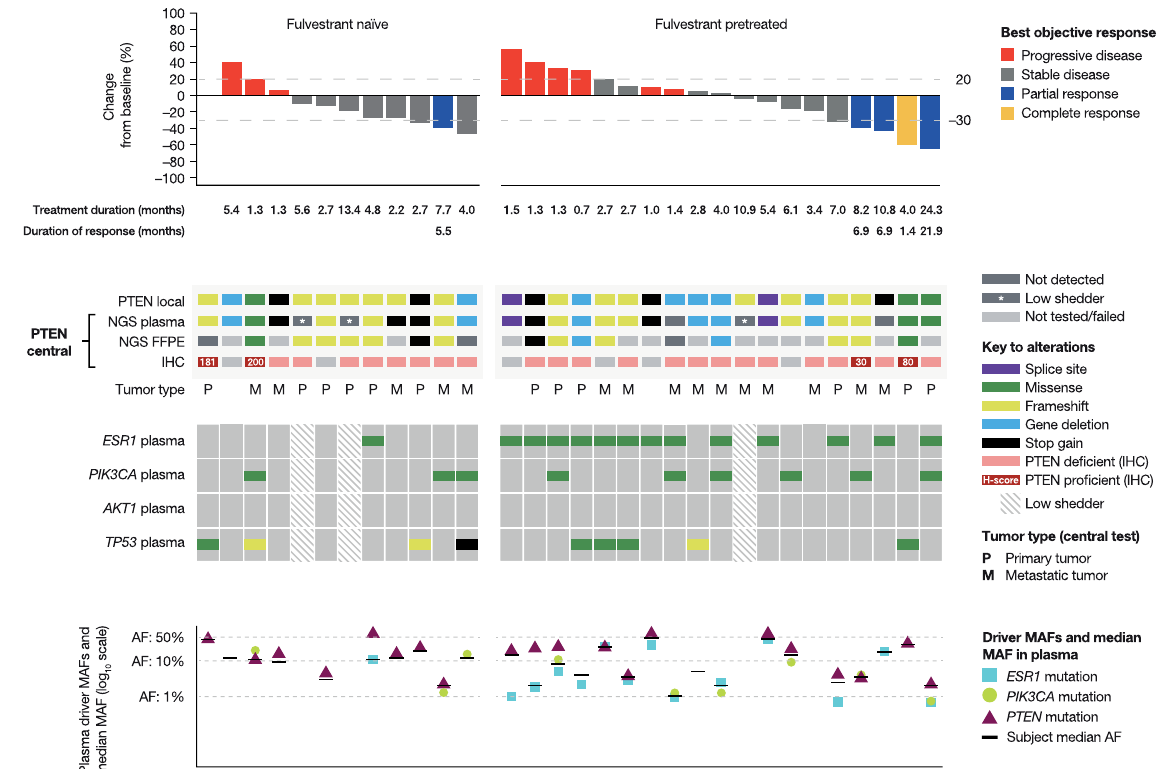
Fig. 2 Best RECIST response, PTEN , and broader mutation pro fi ling in patients with PTEN -mutant ER + MBC treated with capivasertib and fulvestrant. AF allele fraction, ER + estrogen-receptor-positive, FFPE formalin- fi xed paraf fi n-embedded, IHC immunohistochemistry, MAF mutant allele fraction, MBC metastatic breast cancer, NGS next-generation sequencing, RECIST Response Evaluation Criteria in Solid Tumors.